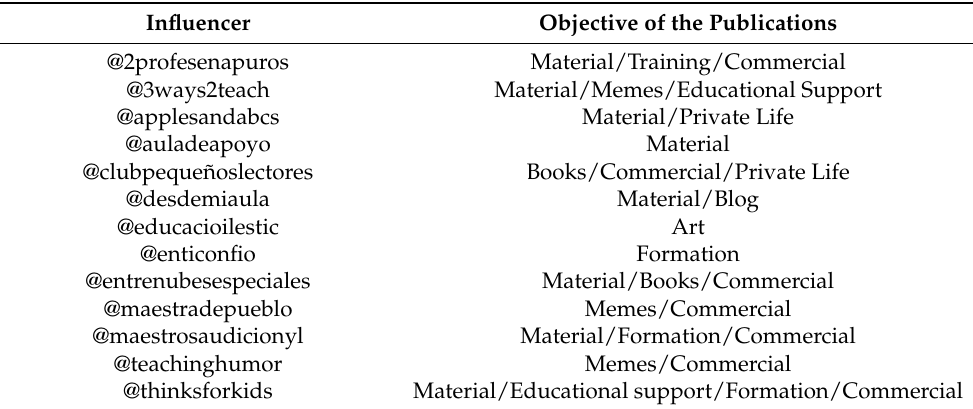
Table 6. Influencers’ objectives according to the content of their profile.